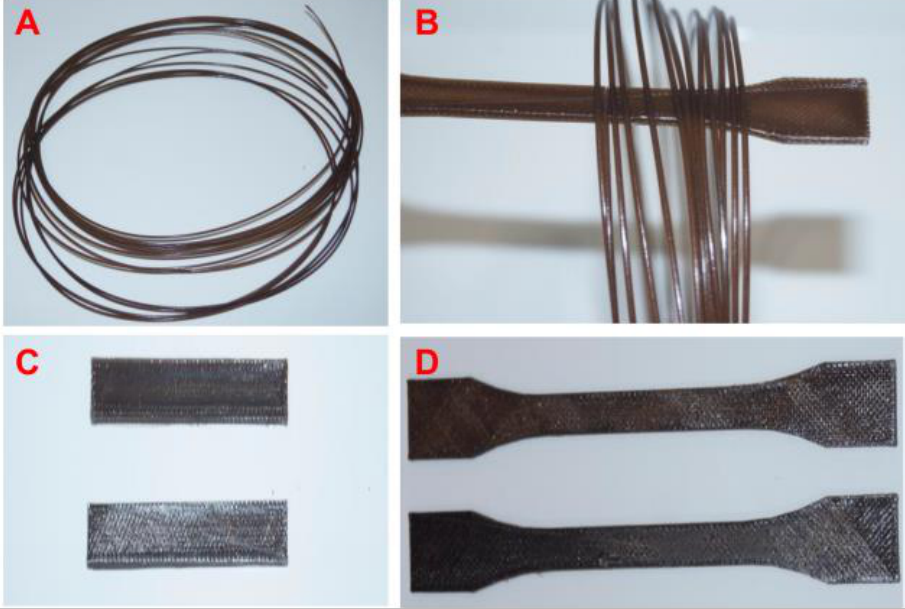
Figure 2. ( A , B ) Three-dimensional printing wire produced with coffee grounds; ( C , D ) standard specimens for the mechanical properties test.